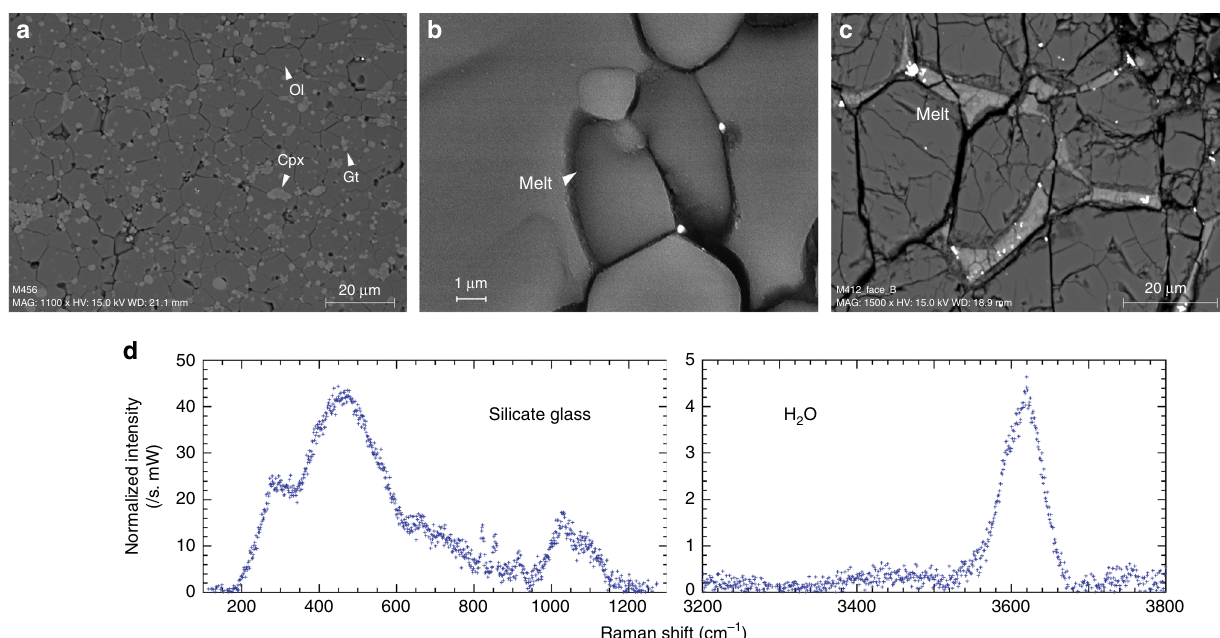
Fig. 2 Sample characterization after high-pressure, high-temperature experiments. a – c FEG-SEM images showing mineral and melt distribution in recovered samples. d Micro Raman spectra of preserved hydrous silicate glass. Low-frequency bands (200 – 1200 cm − 1 ) correspond to vibrations of the alumino-silicate network (weak olivine peaks at 824 and 856 cm − 1 overlap the silicate glass spectrum); High-frequency region (3200 – 3800 cm − 1 ) corresponds to O-H stretching vibrations of OH groups and H 2 O molecules